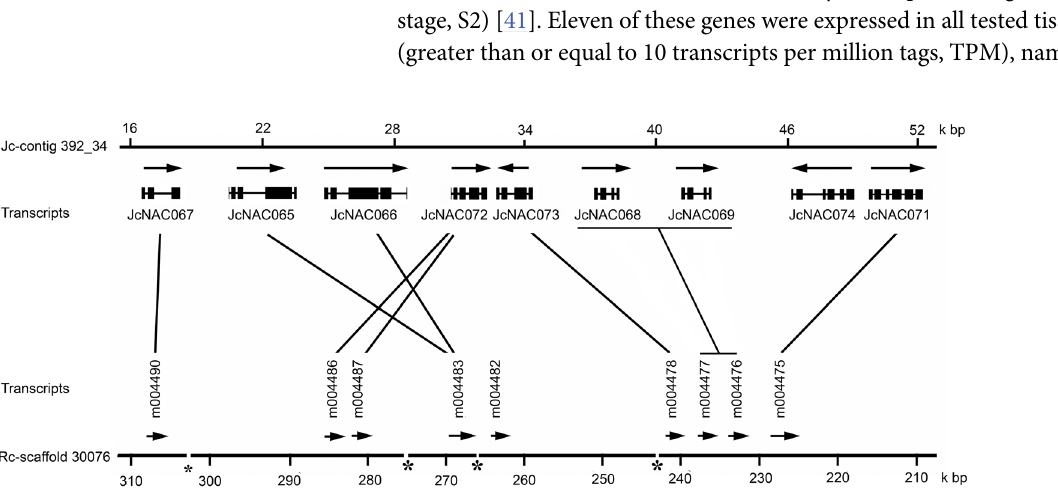
Fig 3. Synteny between physic nut and castor bean genomic segments containing NAC gene clusters. Nine genes in tandem repeats 7 (T7) on Jc- contig 392_34 of physic nut and their orthologs on scaffold 30076 of castor bean were syntenic. The NAC domain of the 30076.m004482 protein is incomplete. The orthologous genes based on the phylogenetic analysis (S2 Fig) were indicated by lines.